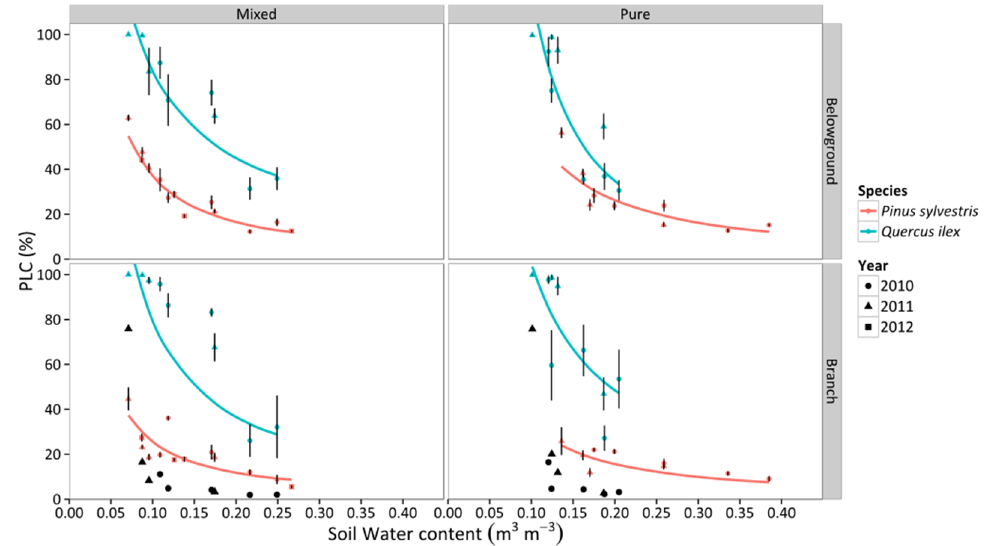
Figure 8. Responses of percentage loss of hydraulic conductivity (PLC) to daytime averages of SWC in two different stand types throughout three consecutive years. Average values for P. sylvestris and Q. ilex trees are shown. Error bars indicate ± 1 SE. The regressions for the different combinations of species and stand type according to best-fitting models are also depicted ( cf. Table S4). Black symbols represent the PLC values obtained following the vulnerability curves from Martin-StPaul et al. [48] for Q. ilex .